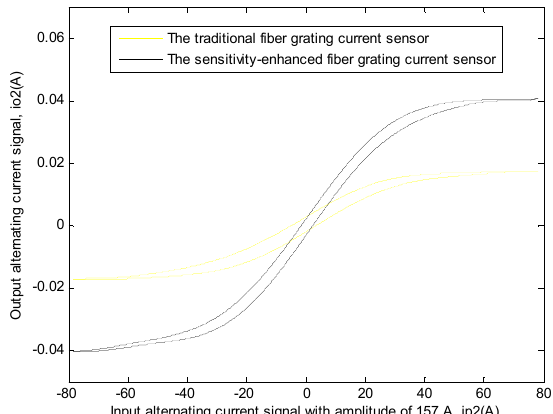
Figure 11. The transfer function relationship curves of the two sensors between output alternating current signal ( i o 2 ) and input alternating current signal with amplitude of 157 A( i p 2 ), respectively. The black curve shows the transfer function relationship of the sensitivity-enhanced fiber grating current sensor. The yellow curve shows the transfer function relationship of the traditional fiber grating current sensor.